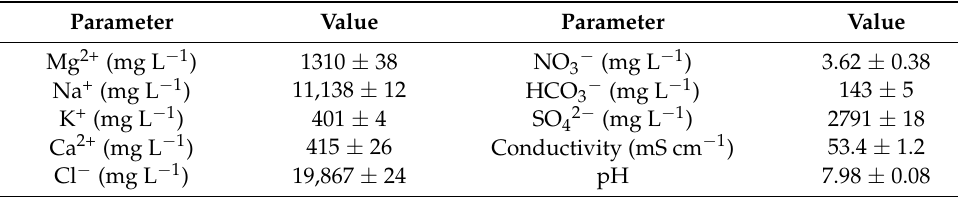
Table 5. Seawater composition at San Jorge